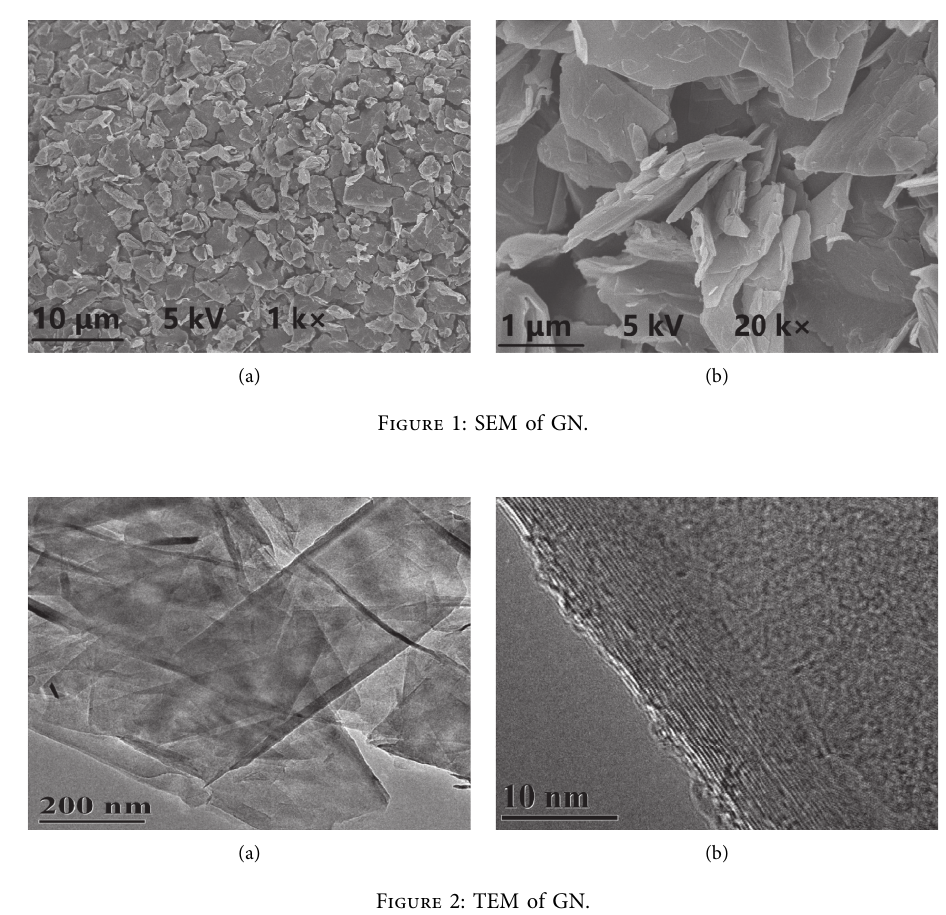
Figure 2: TEM of